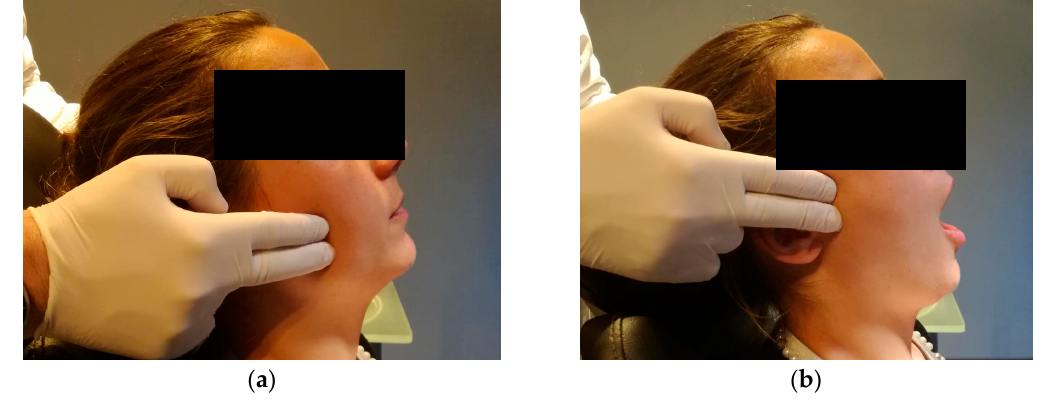
Figure 4. Extra-oral examination with the palpation of the masseter muscle and TMJ. ( a ) Masseter muscle palpation with the patient in rest position; ( b ) TMJ palpation during mouth opening/closing.